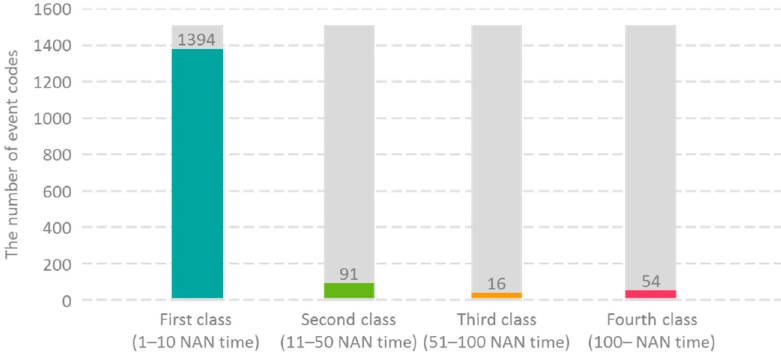
Figure 5. The number of event codes with regard to maintenance categories. ( x -axis indicates four categories of NAN periods and their corresponding length of NAN times; y -axis is the number of event codes).